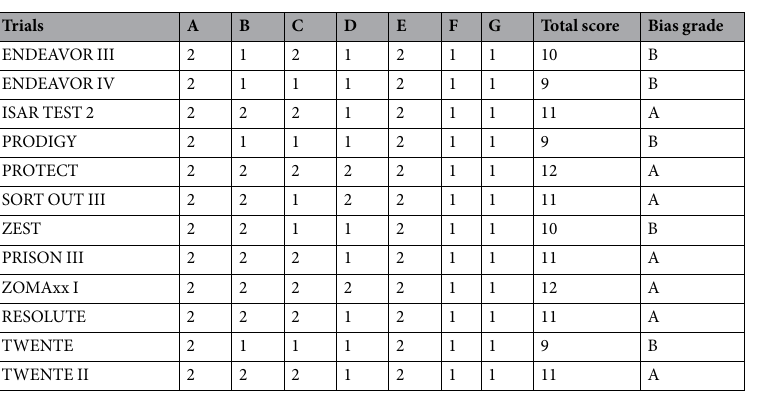
Table 2. Bias risk assessment of the trials with reference to the Cochrane Collaboration. The seven components recommended by the Cochrane Collaborations to assess bias risk: A: Sequence generation B: Allocation sequence concealment C: Blinding of participants and personnel D: Blinding of outcome assessment E: Incomplete outcome data F: Selective outcome reporting G: Other potential sources of bias.